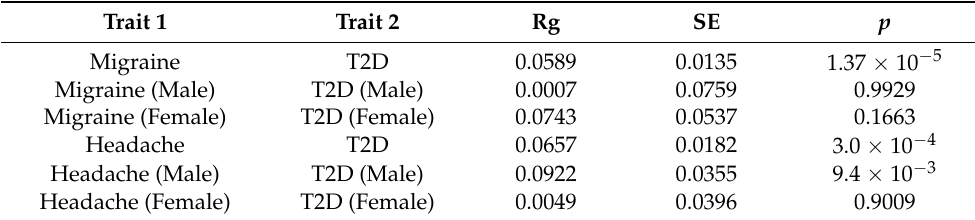
Table 1. Combined and sex-stratified genetic correlation between migraine and headache with T2D on a liability scale. Trait 1 Trait 2 Rg SE p Migraine T2D 0.0589 0.0135 1.37 × 10 − 5